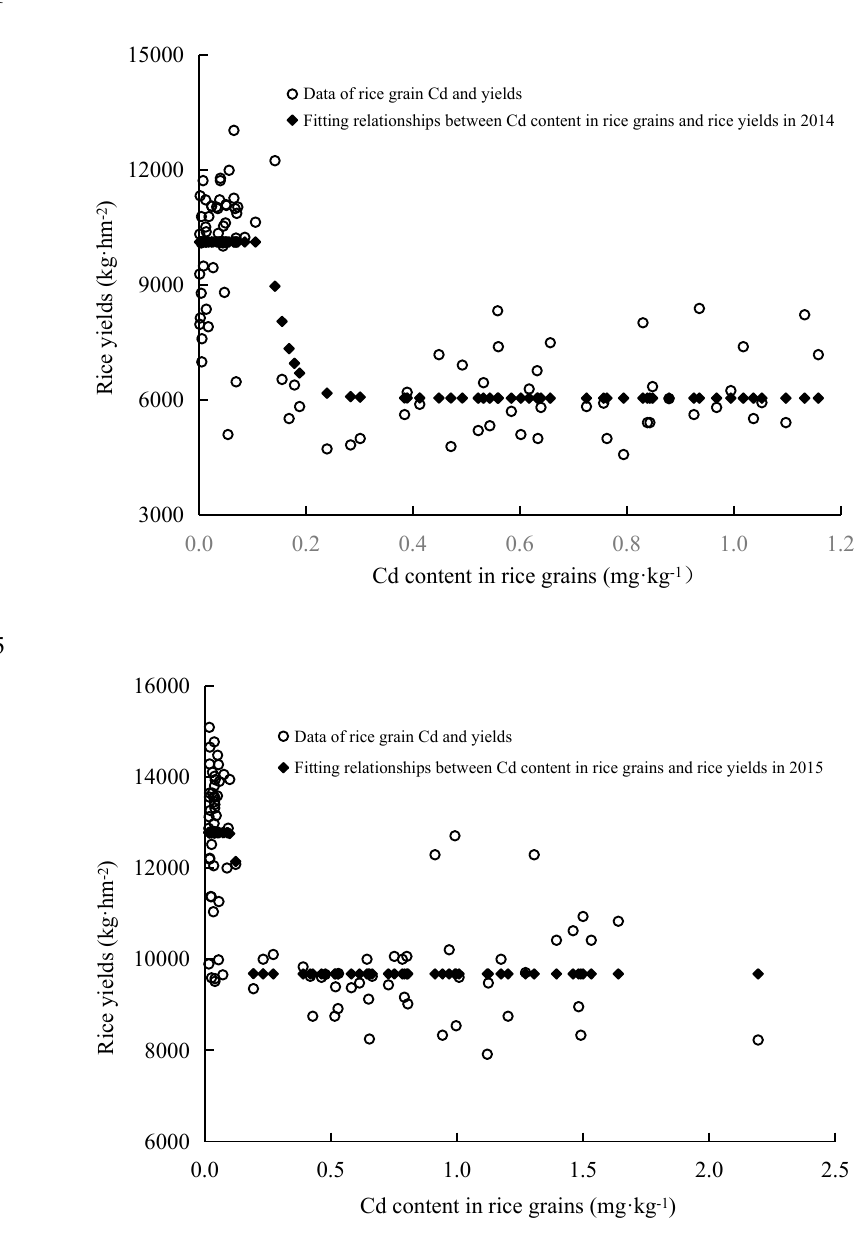
Figure 3. Relationships between Cd content in rice grains and rice yields: ( a ) 2014, ( b ) 2015.